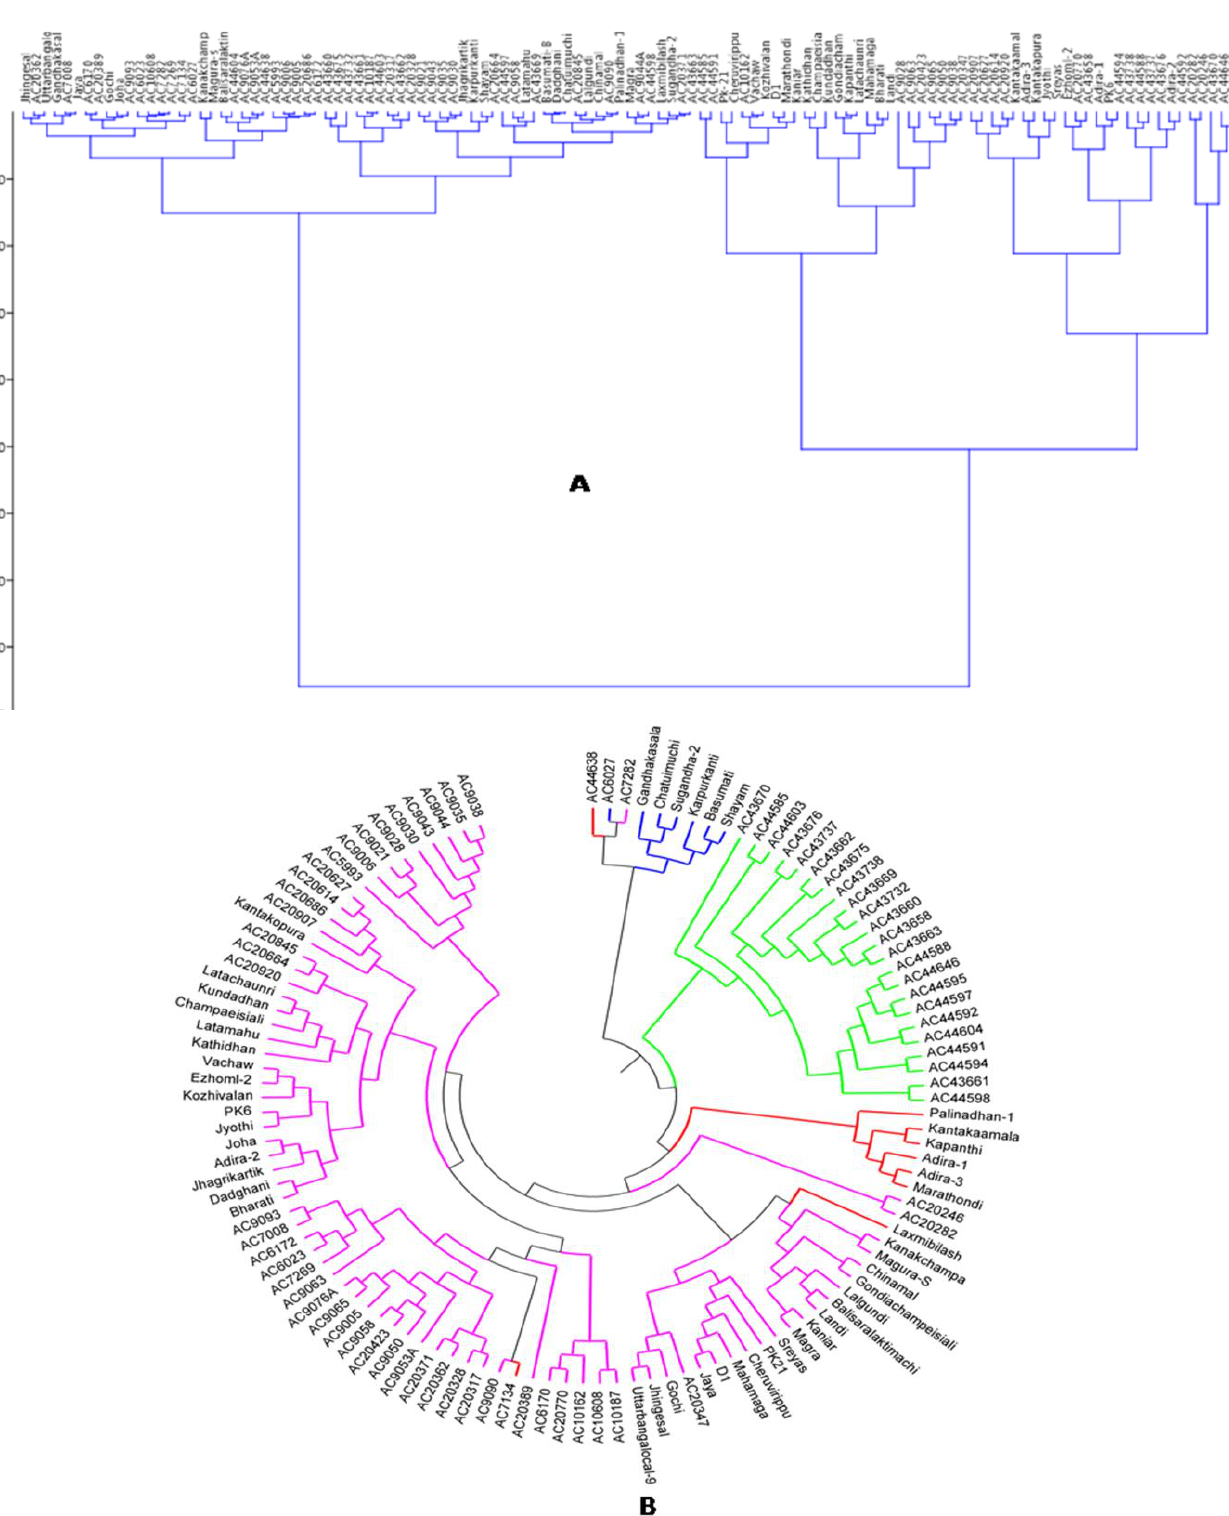
Figure 8. ( A ) Grouping of the germplasm lines present in the panel population by Ward’s clustering based on the six antioxidant traits. ( B ). Unrooted tree using unweighted-neighbor joining method depicting clustering patterns of 117 germplasm lines genotyped by 131 molecular markers colored on the basis of the subpopulations obtained from structure analysis (SP1: pink; SP2: green; SP3: blue; Admix: